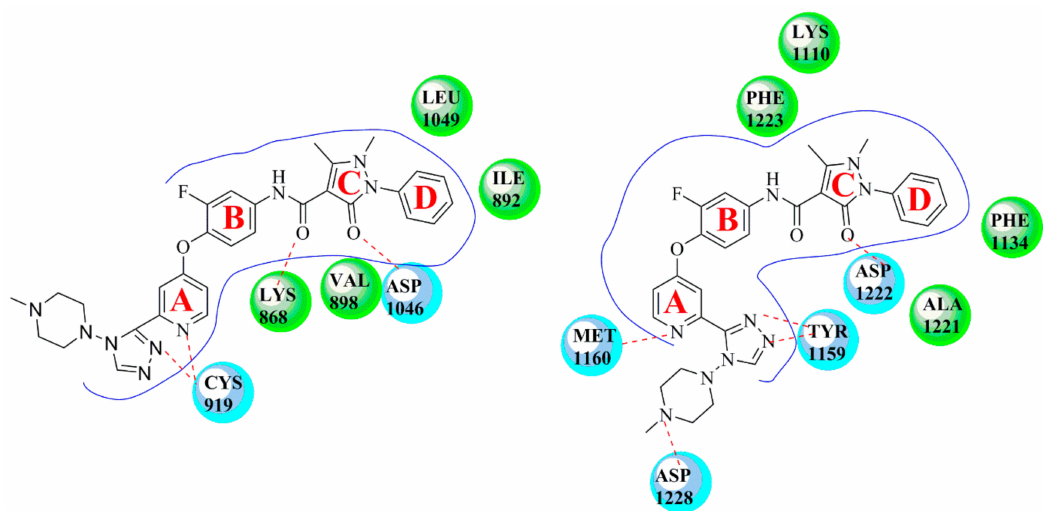
Figure 5. Docking of compound 4 with VEGFR-2 (PDB code: 3U6J) and c-Met (PDB code: 3LQ8) (Most dual-target VEGFR / c-Met inhibitors can be divided into four parts: A, B, C and D. Part A: The main structural skeleton, mainly nitrogen-containing heterocycles. Part B: Substituted benzene ring; Part C: Meet the ‘5-atom regulations’. Part D; Benzene